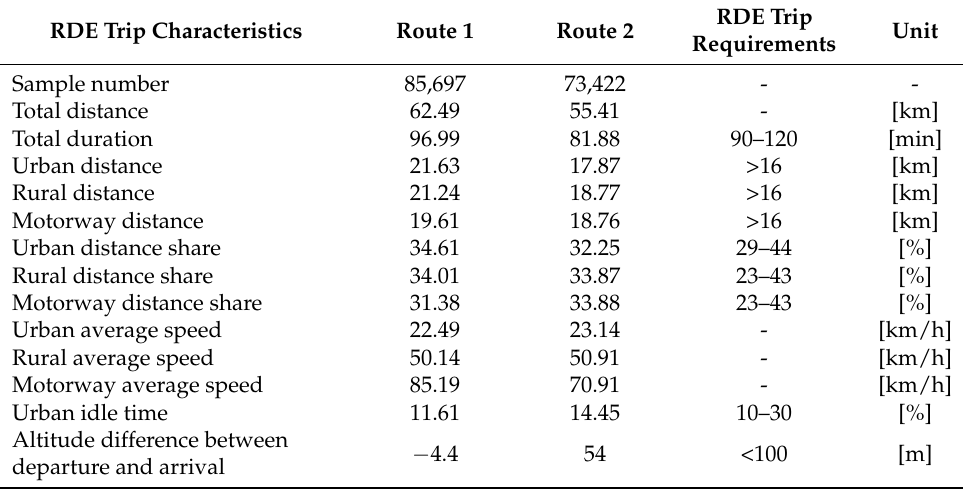
Table 2. Trip characteristics for the RDE